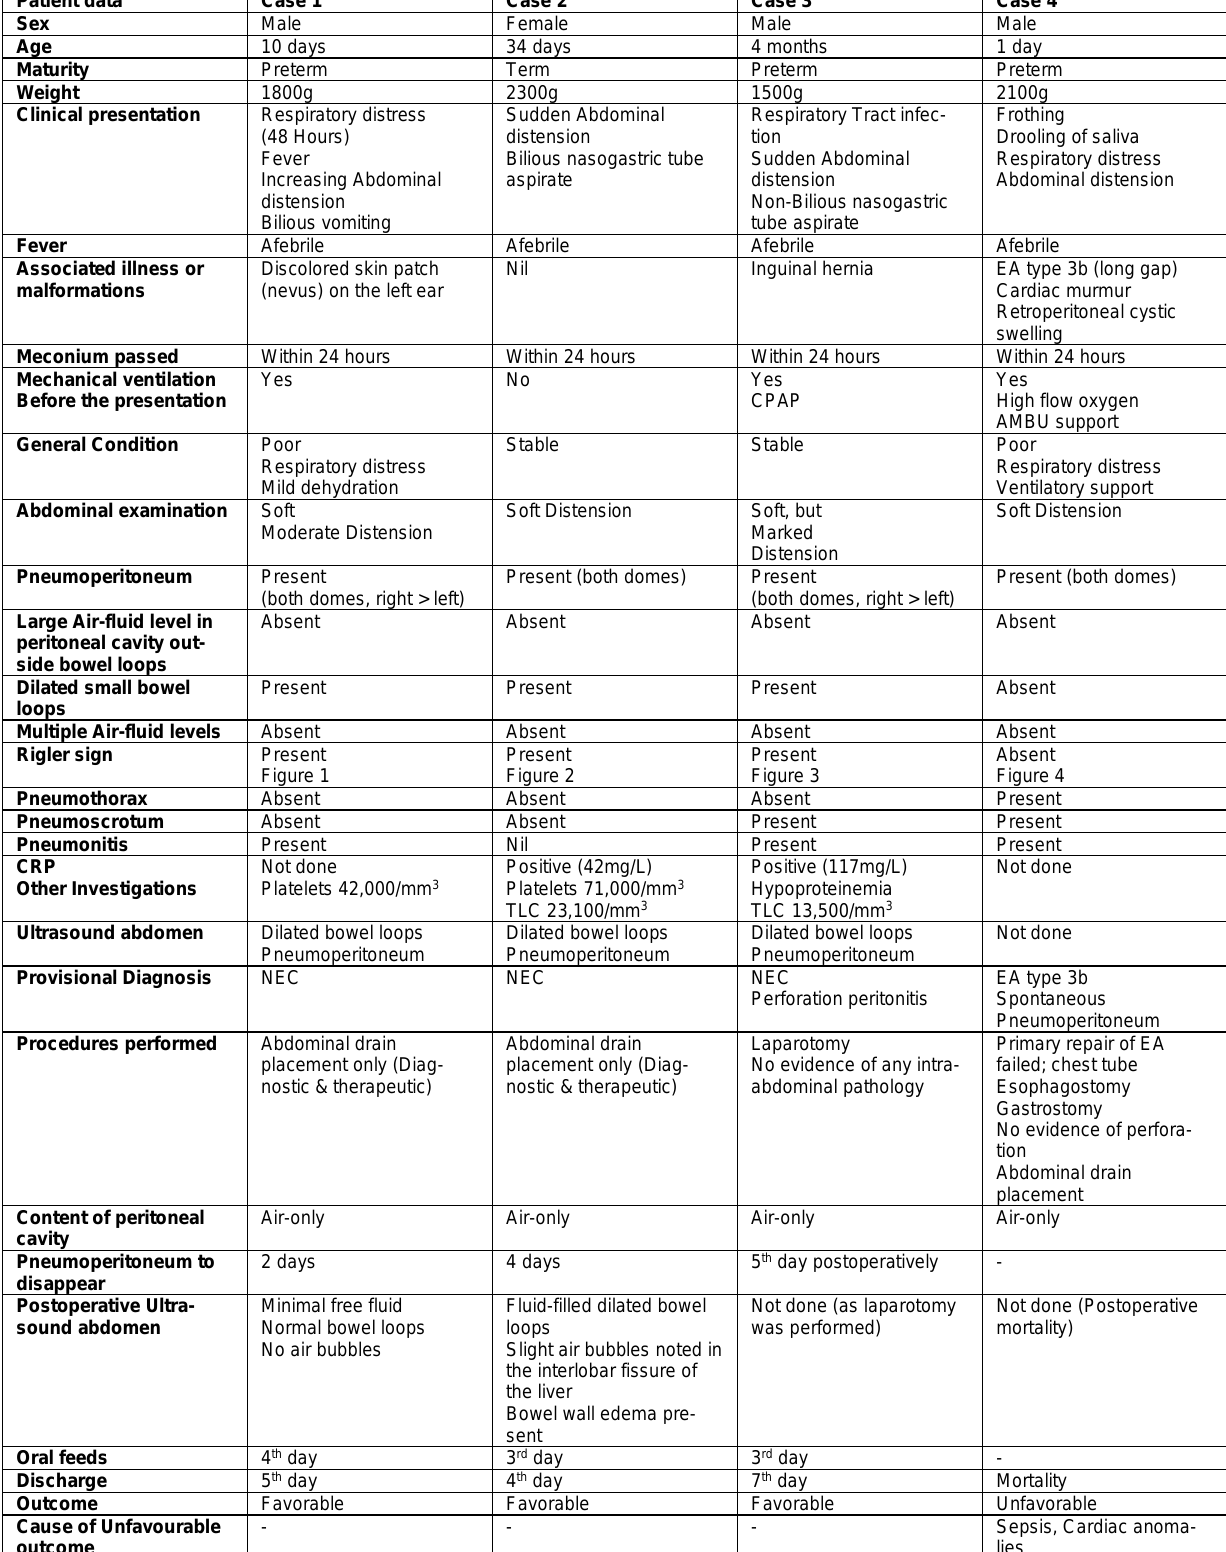
Table 1: Clinical details, investigations undertaken, management details, and outcomes of patients with